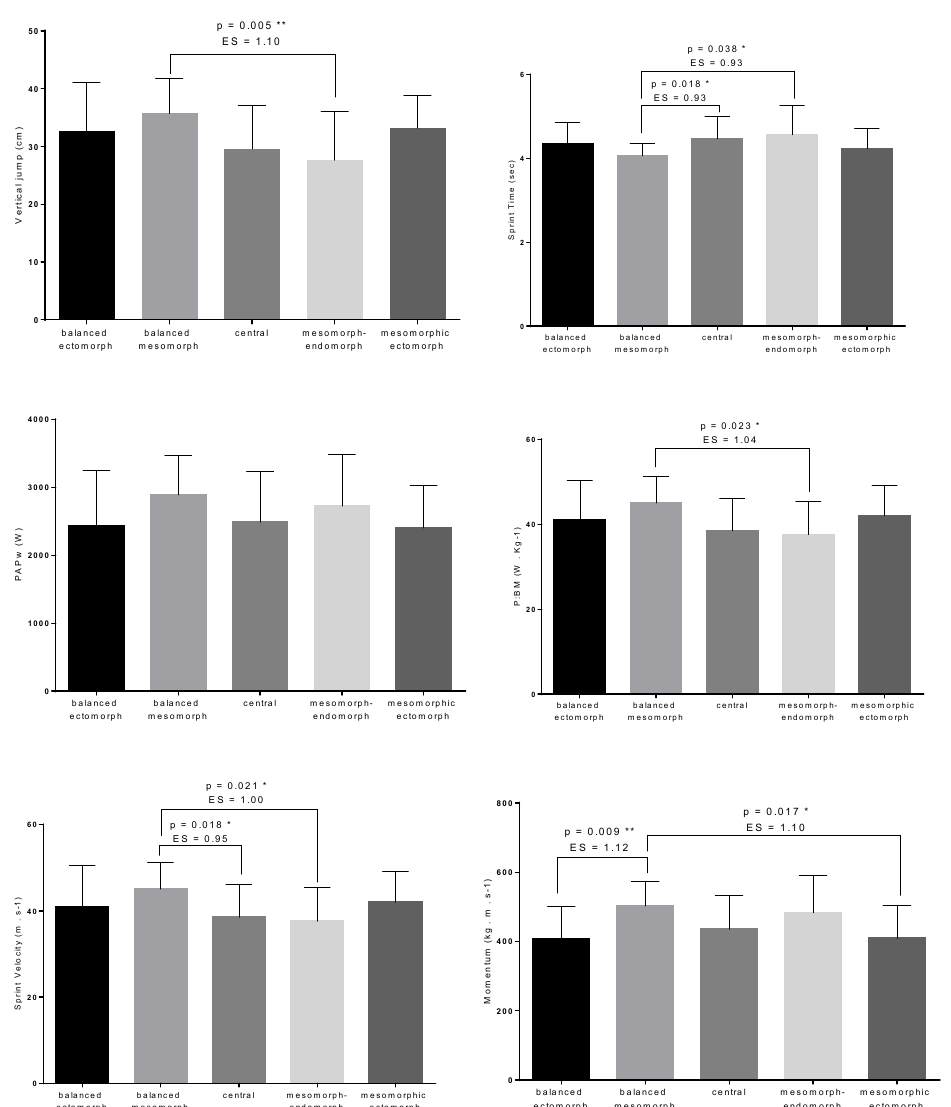
Figure 2. Multiple pairwise comparisons for the jumping and sprinting variables in participants by dominant somatotype (* = p < 0.05; ** = p < 0.01). dominant somatotype (* = p < 0.05; ** = p <